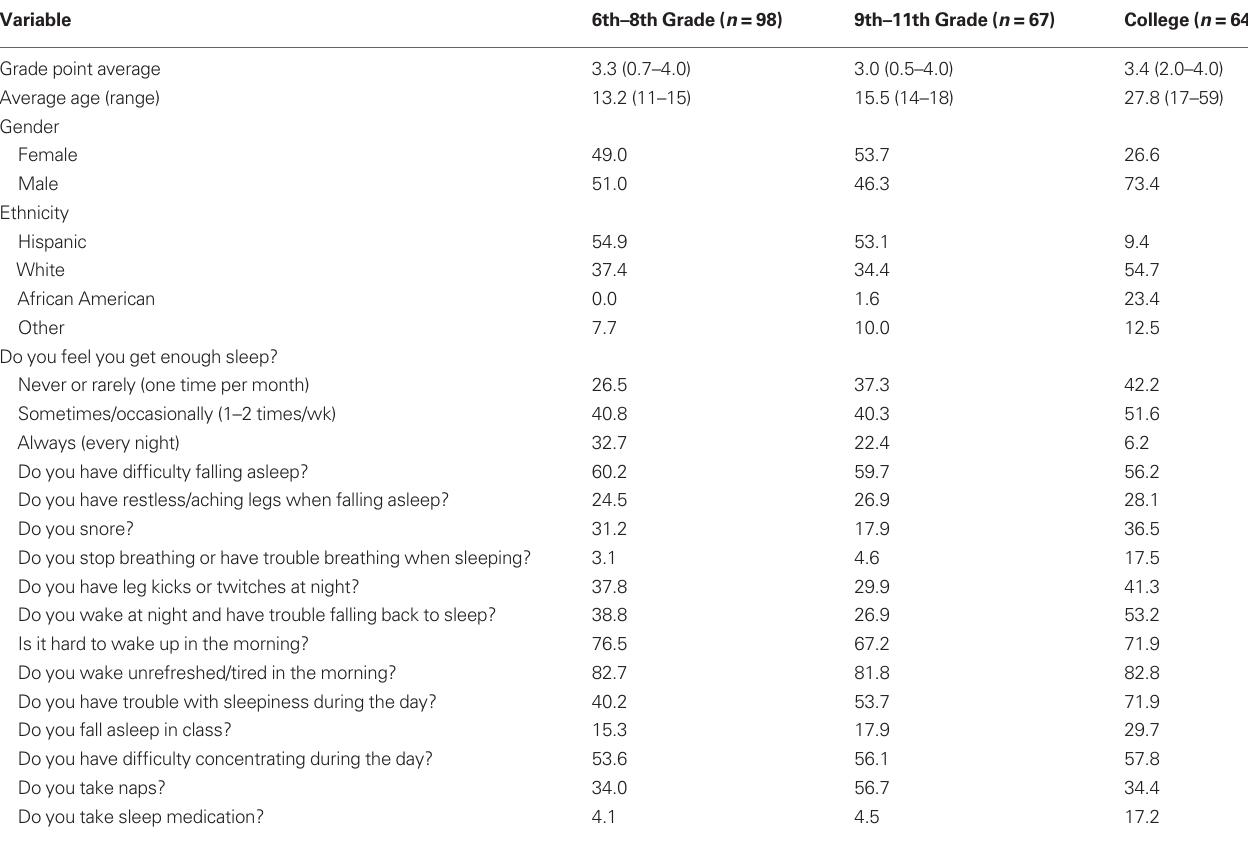
Table 1 | Demographic and sleep variables for all three